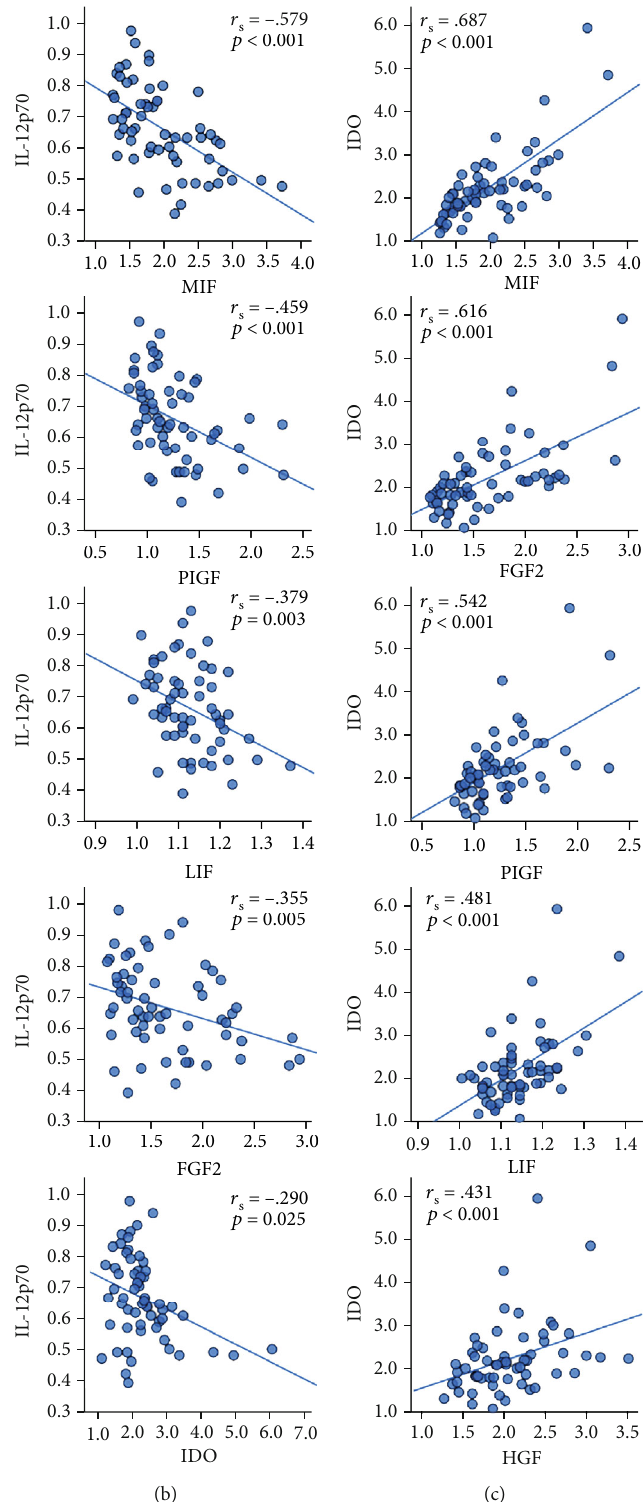
Figure 6: Correlations of relative concentration of analytes in cocultures of dendritic cells and ASC. (a) Correlation matrix of investigated factors. (b) IL-12p70 correlates inversely with ASC-associated factors, while the concentration of IDO correlates with the presence of trophic factors (c). Spearman ’ s rho; n = 60 , resulting from 5 ASC donors, 4 DC donors, and 3 cell